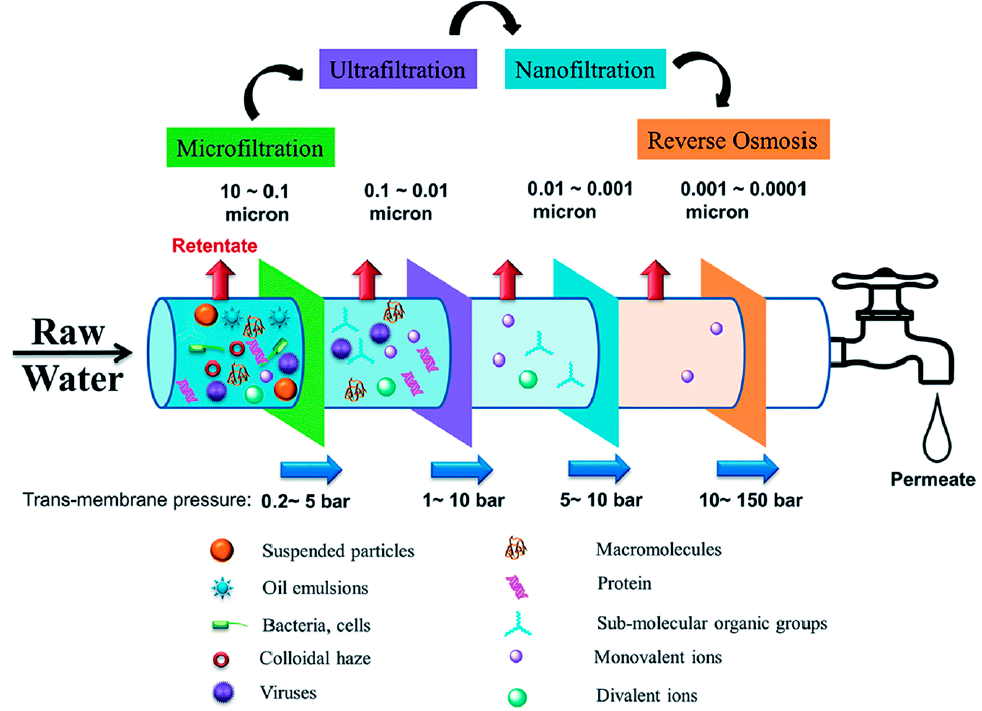
Figure 1. Trans-membrane pressure processes for water treatment technologies with different pore sizes. Reproduced with permission from Reference [13]. Copyrights 2018, Elsevier Science Ltd. Table 1. List of different water pollutants with their sources and adverse effects.